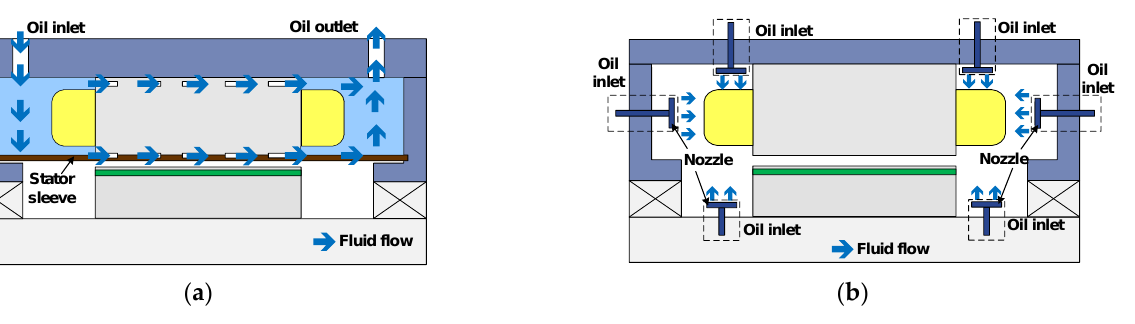
Figure 13. Direct forced liquid cooling. ( a ) Stator immersion. ( b ) Spray cooling (three oil inlets on either side could be assembled